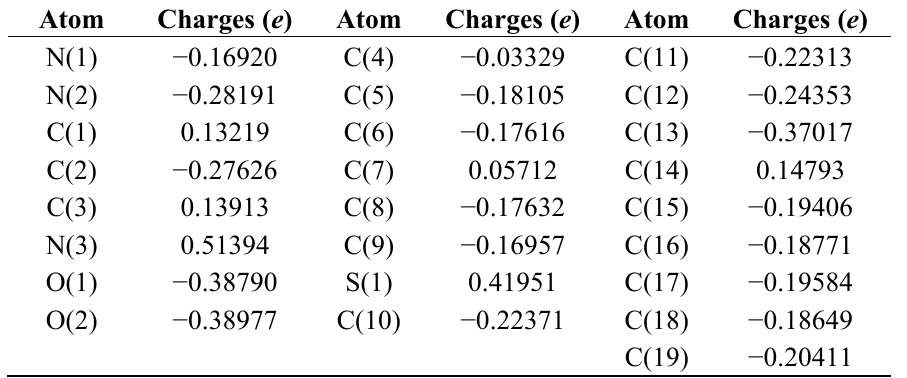
Table 3. NPA atomic charge distributions obtained at B3LYP/6-311G** level.